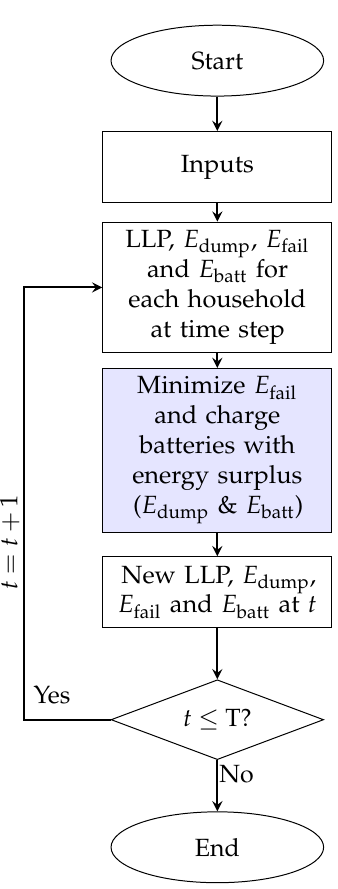
Figure 5. Steps involved in the modeling of energy sharing between the SHS for a given number of households. T denotes the total time period of